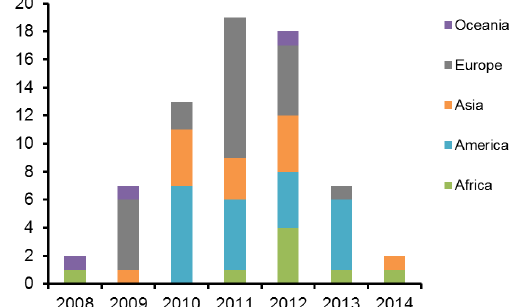
Figure 2. Yearly distribution of NMS incorporation on Twitter.